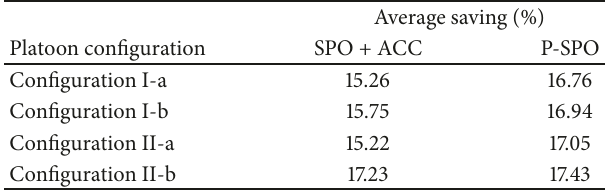
Table 2: The average fuel savings obtained in the simulations for a heterogeneous platoon of two HDV, with different mass configurations, over all the road profiles. The middle column shows thefuelsavingsobtainedwhentheleadvehiclefollowstheoptimized speed profile and the follower vehicles follow the same profile while maintaining the desired intervehicle distance (using ACC). The desired intervehicle distance is set to the minimum allowed safe distance; see (12). The right-most column shows the fuel savings obtained when each vehicle follows its own optimized speed profile. All the fuel savings are normalized with respect to the baseline case, i.e., CC+ACC where the lead vehicle drives at the constant speed of 80 km/h and the inter-vehicle distance is set to the allowed